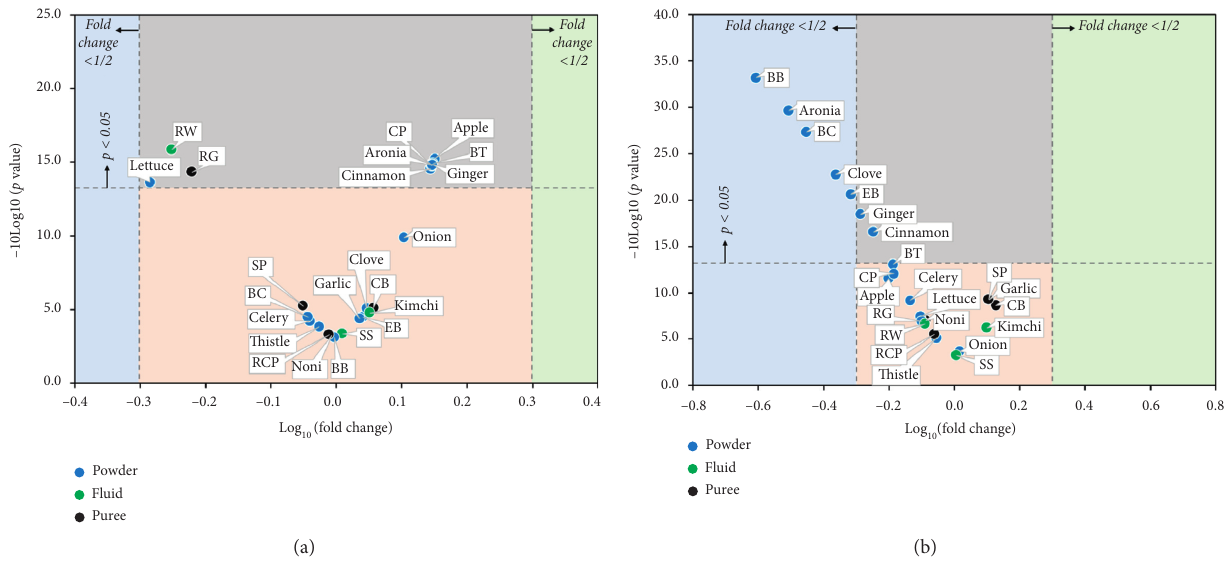
Figure 2: (a) Volcano plots for peroxide value (POV) and (b) 2-thiobarbituric acid-reactive substances (TBARS) of pork patties. SS, soy sauce; RW, red wine; RCP, red chili paste; SP, soybean paste; RG, red ginseng; BC, blackcurrant; EB, elderberries; CP, chili pepper; BB, blueberries; CB, cherry berry; BT, black tea.